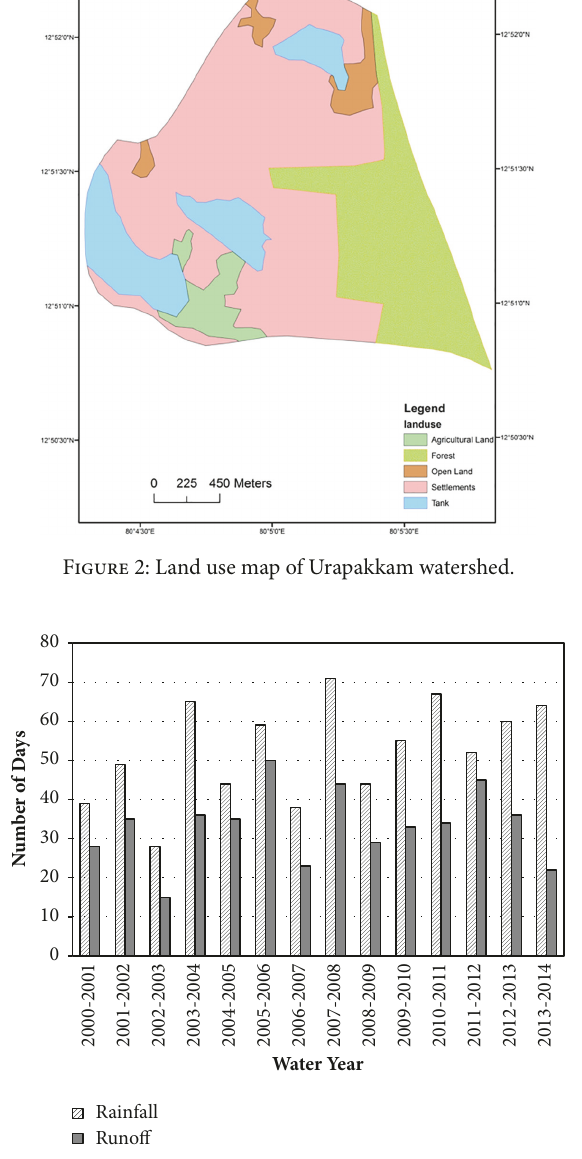
Figure 3: Number of days with rainfall and runoff by NRCS